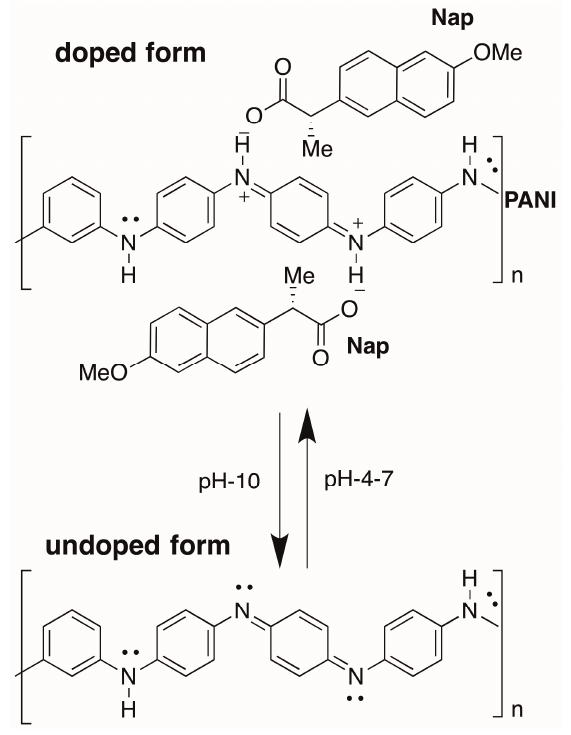
Figure 9. Doped and un-doped form of